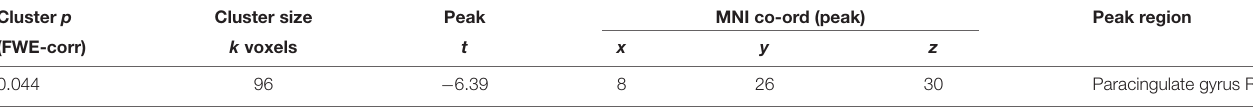
TABLE 2 | Whole-brain voxel-wise rmANOVA of resting-state functional connectivity (rsFC) with left posterior hippocampus. Cluster p Cluster size Peak MNI co-ord (peak) Peak region (FWE-corr) k voxels t − 6.39 26 30 Paracingulate gyrus R